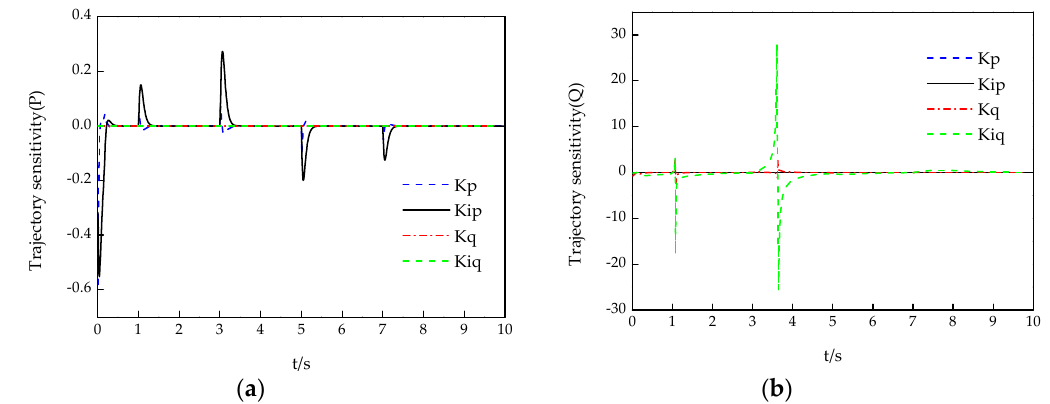
Figure 4. Reference value of the voltage at the point of common coupling (PCC).